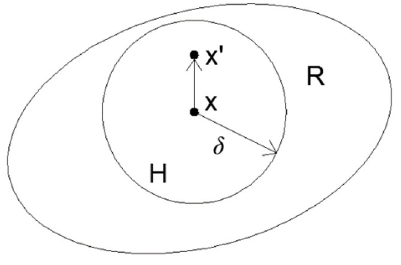
Figure 1. Any point x in R interacts directly with point x’ in horizon H by the bond.